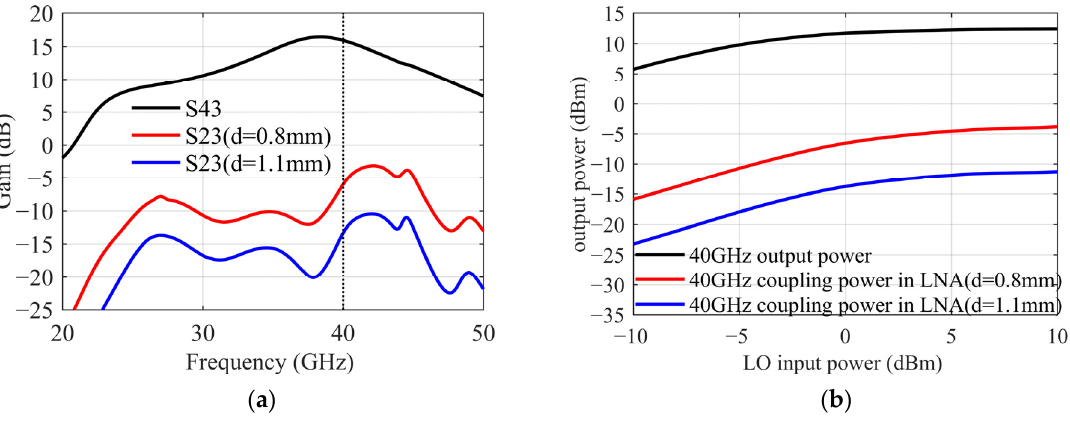
Figure 13. ( a ) 40 GHz amplifier gain and coupling. ( b ) 40 GHz amplifier output power and coupling power.